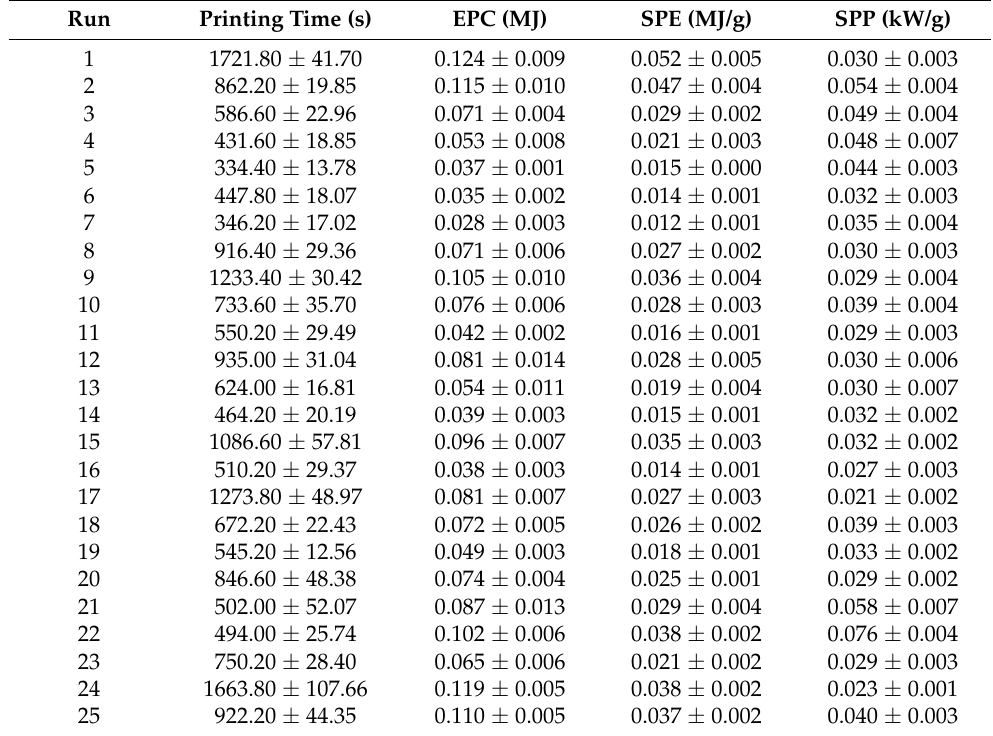
Table 3. Average and standard deviations values of measured responses for printing time, EPC, SPE, and